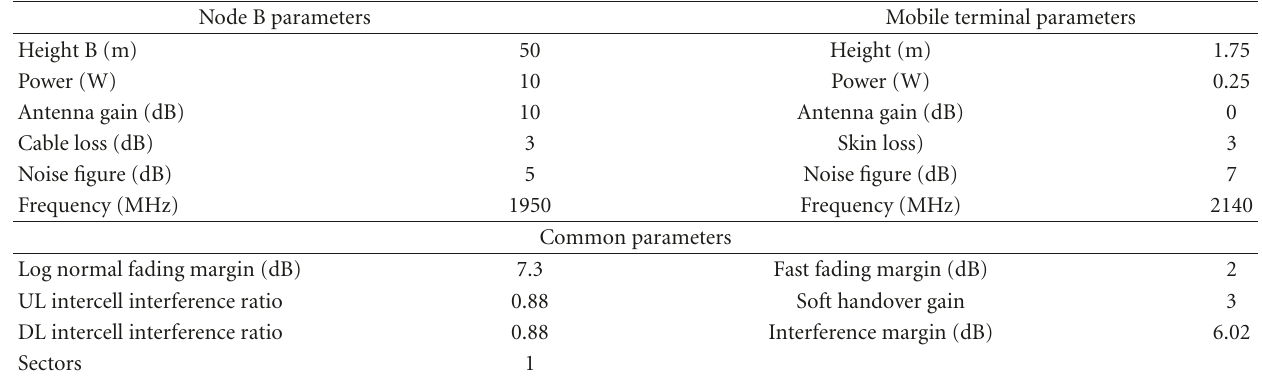
Table 1: Radio propagation parameters.